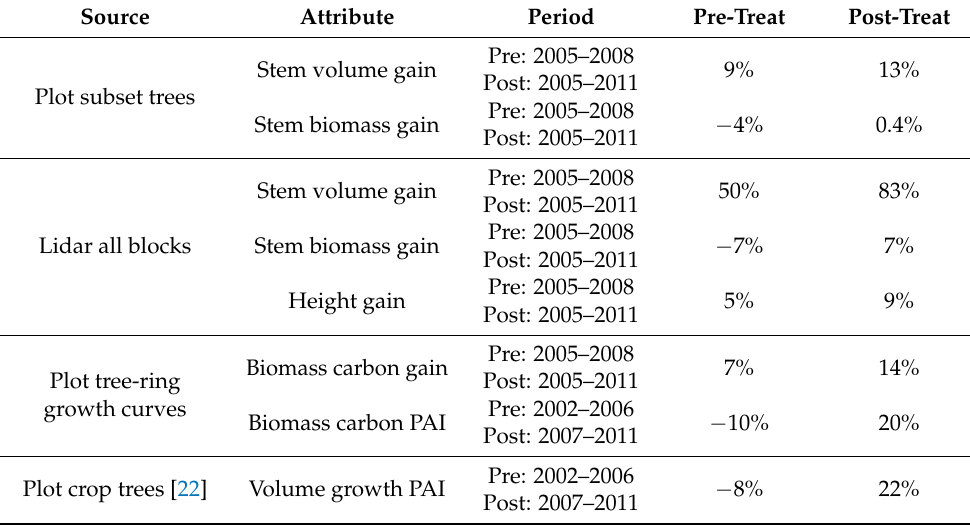
Table 5. Treatment effect method comparison showing unweighted values (((Fertilized/Control) − 1) × 100) in pre- and post-treatment periods for stem volume (m 3 ha − 1 ), stem biomass (Mg ha − 1 ), and height (m) cumulative increment (gain) for plot subset trees and LiDAR blocks, and above- ground biomass carbon gain (Mg C ha − 1 ) from a model reconstruction approach using plot tree-ring growth curves. Comparisons are also shown for periodic annual increment (PAI) of above-ground biomass carbon (Mg C ha − 1 yr − 1 ) from tree-ring curves for the same periods as volume growth (m 3 ha − 1 yr − 1 ) in